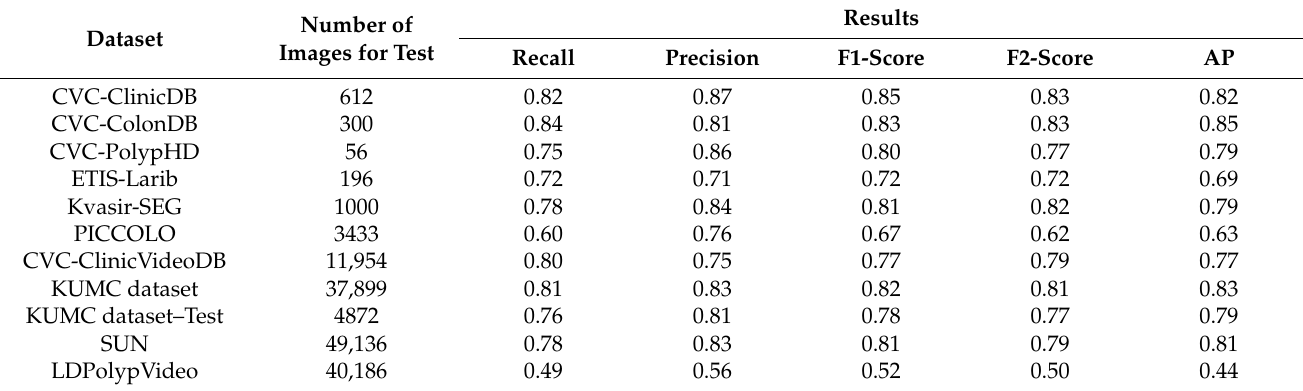
Table 3. Performance results of our model when evaluated on the ten selected public colonoscopy image datasets.